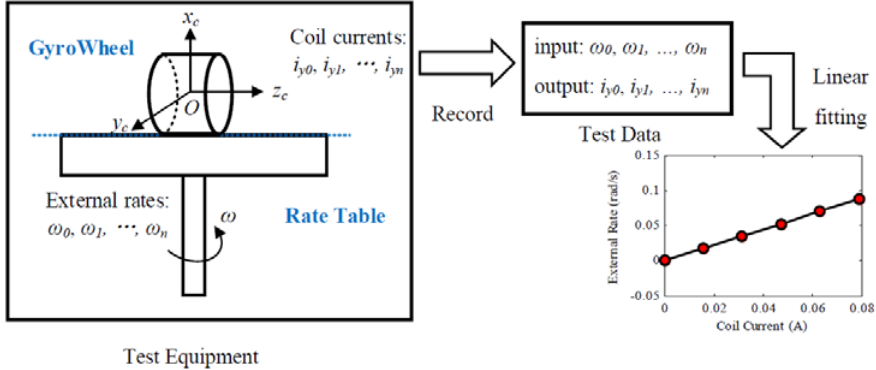
Figure 4. Schematic of angular rate test.